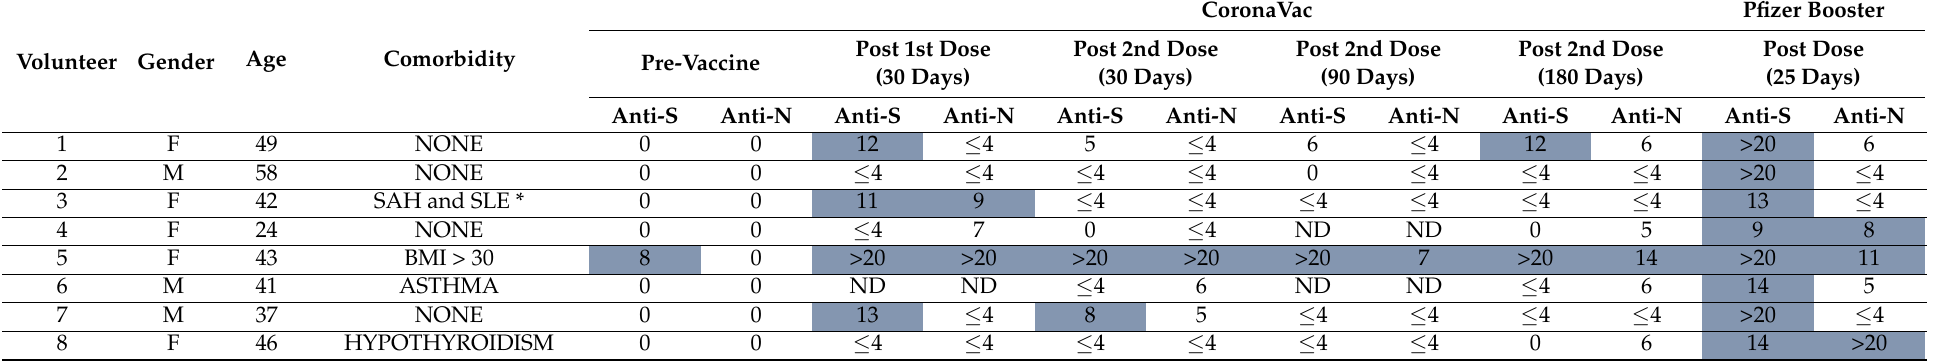
Table 1. Response Specific COVID-19 interferon-gamma (IFN- γ ) Anti-S and Anti-N